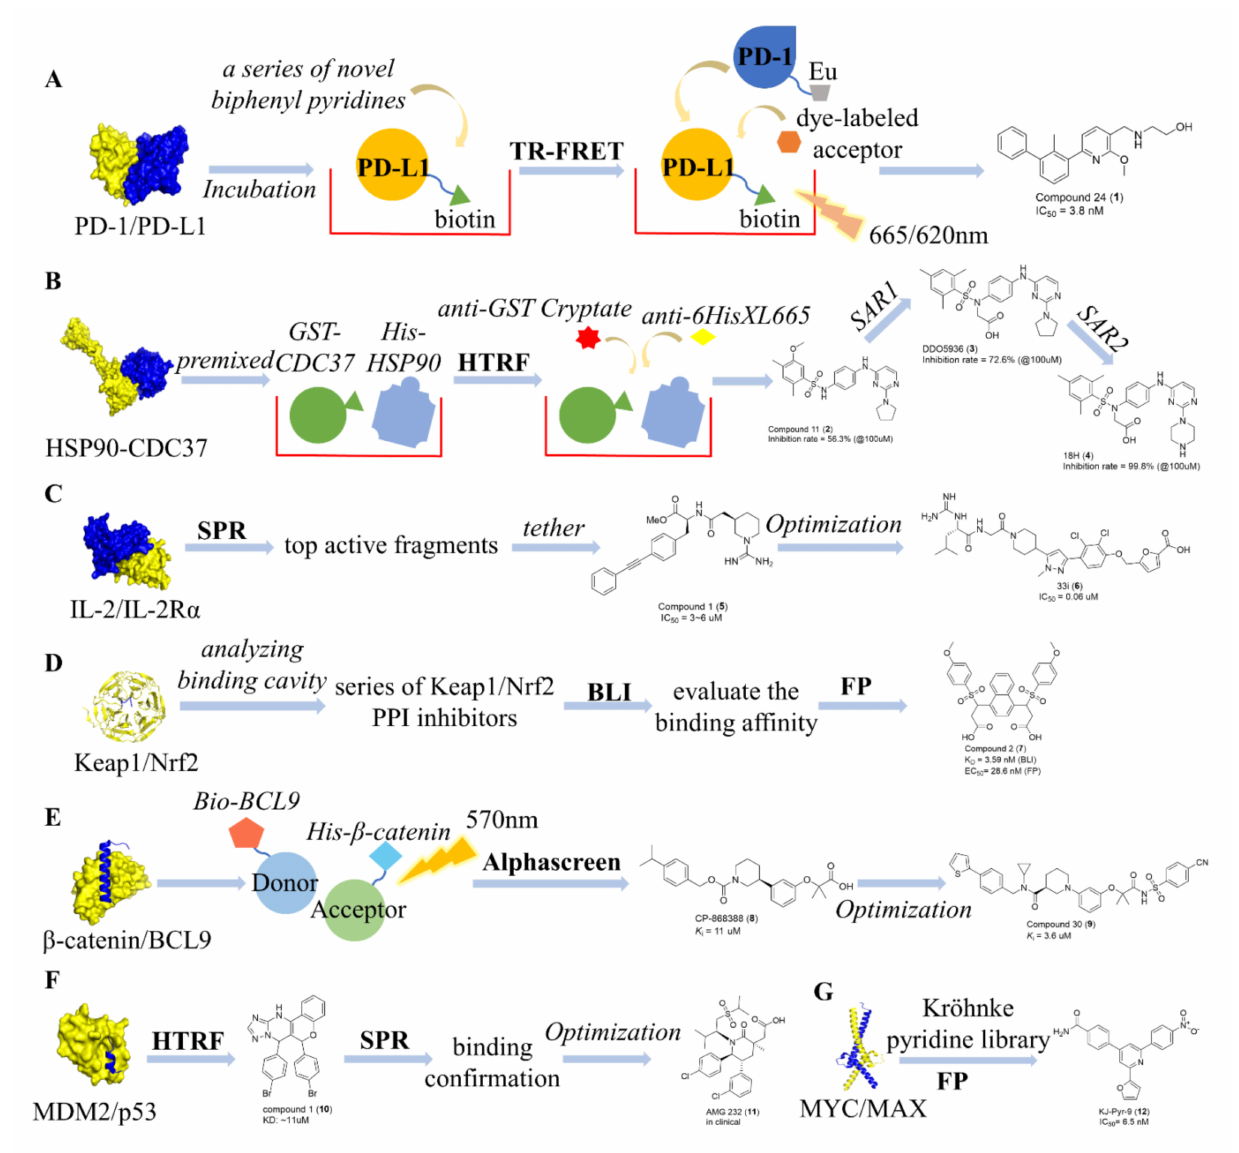
Figure 8. Representative inhibitors of different types of PPIs discovered by current methods. ( A ) PD- 1/PD-L1 (type I) inhibitor compound 24 was identified by HTRF technology. ( B ) HSP90-CDC37 (type I) inhibitor 18H was also identified by HTRF technology. ( C ) IL-2/IL-2R α (type II) inhibitor 33i was discovered by SPR and tether methods. ( D ) Keap1/Nrf2 (type III) inhibitor compound 2 was discovered by BLI and FP strategies. ( E ) β -catenin/BCL9 (type IV) inhibitor compound 30 was identified by AlphaScreen. ( F ) MDM2/p53 (type IV) inhibitor AMG232 was found by the HTRF and SPR methods. ( G ) MYC/MAX (type V) inhibitor KJ-Pyr-9 was discovered by an FP